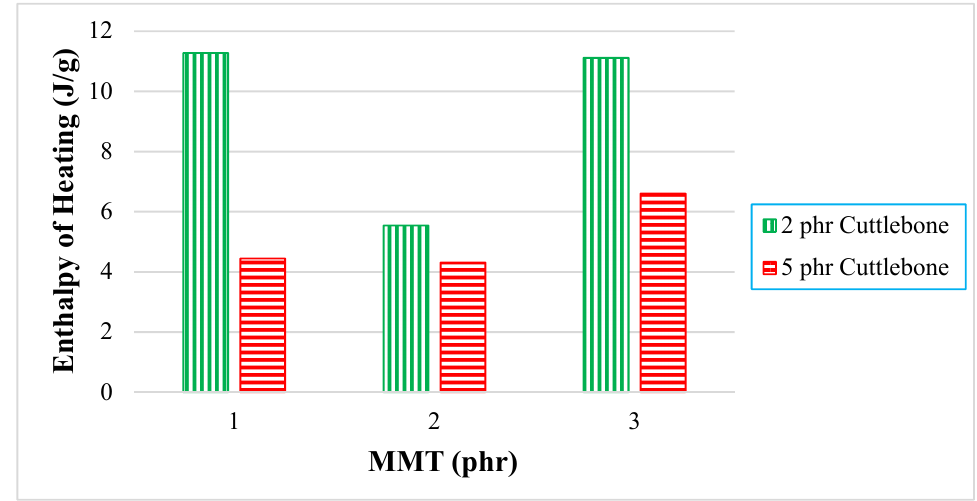
Figure 4. Effect of increasing MMT and calcined cuttlebone loading level on enthalpy of